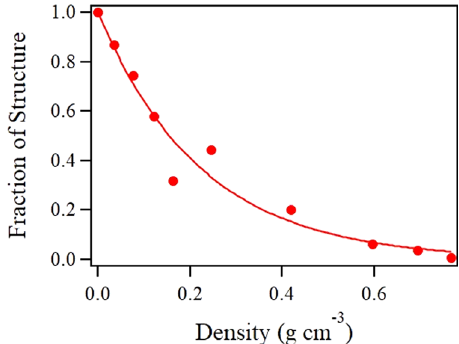
Fig. 5 Fraction of diffuse vibrational structure in the CO 2 monomer spectrum. The extent of vibrational structure inherent to the CO 2 spectrum shows an exponential decrease as a function of increasing density for supercritical CO 2